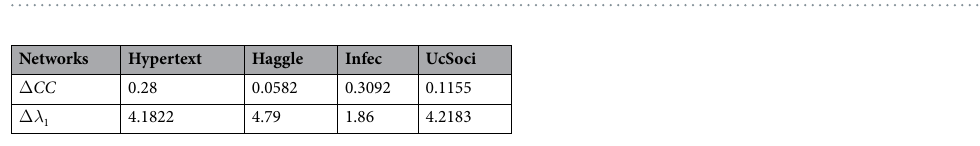
Table 3. Average age of links selected by predictors. The bold data are averaged over ten runs and obtained under the optimal parameters.